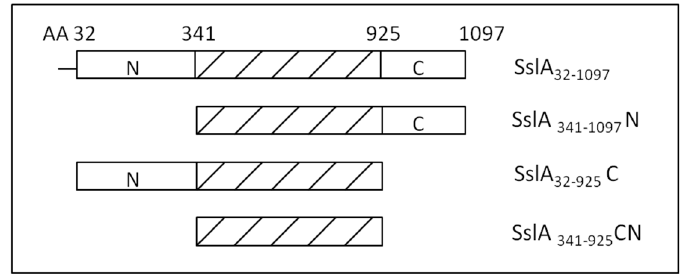
Figure 1. Creation of SslA truncation derivatives. By deletion of the N-terminal part of the SslA protein sequence (amino acids 1-341), SslA 341-1097 N is created. Similarly, by deletion of the C-terminal part (amino acids 925-1097), SslA 32-925 C was constructed. Finally a construct having both, the N- and C-terminals truncated (amino acids 1-341 and 925-1097) named SslA 341-925 CN was designed.